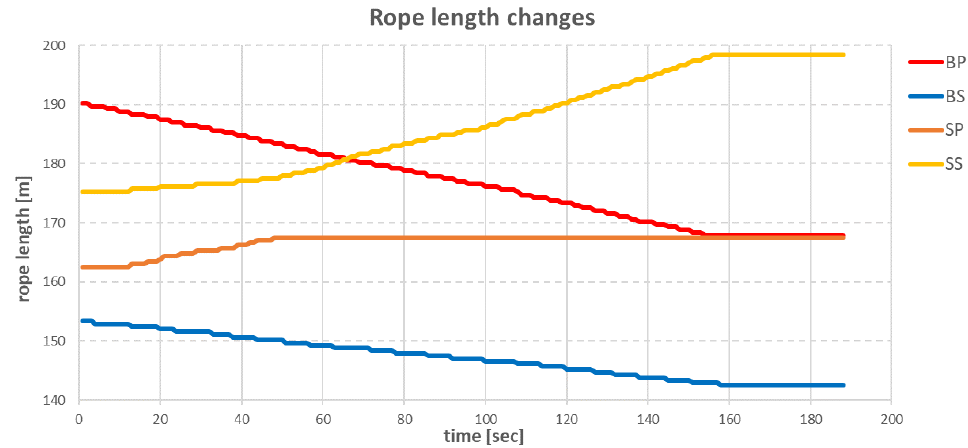
Figure 15. Changes in the length of individual ropes during the